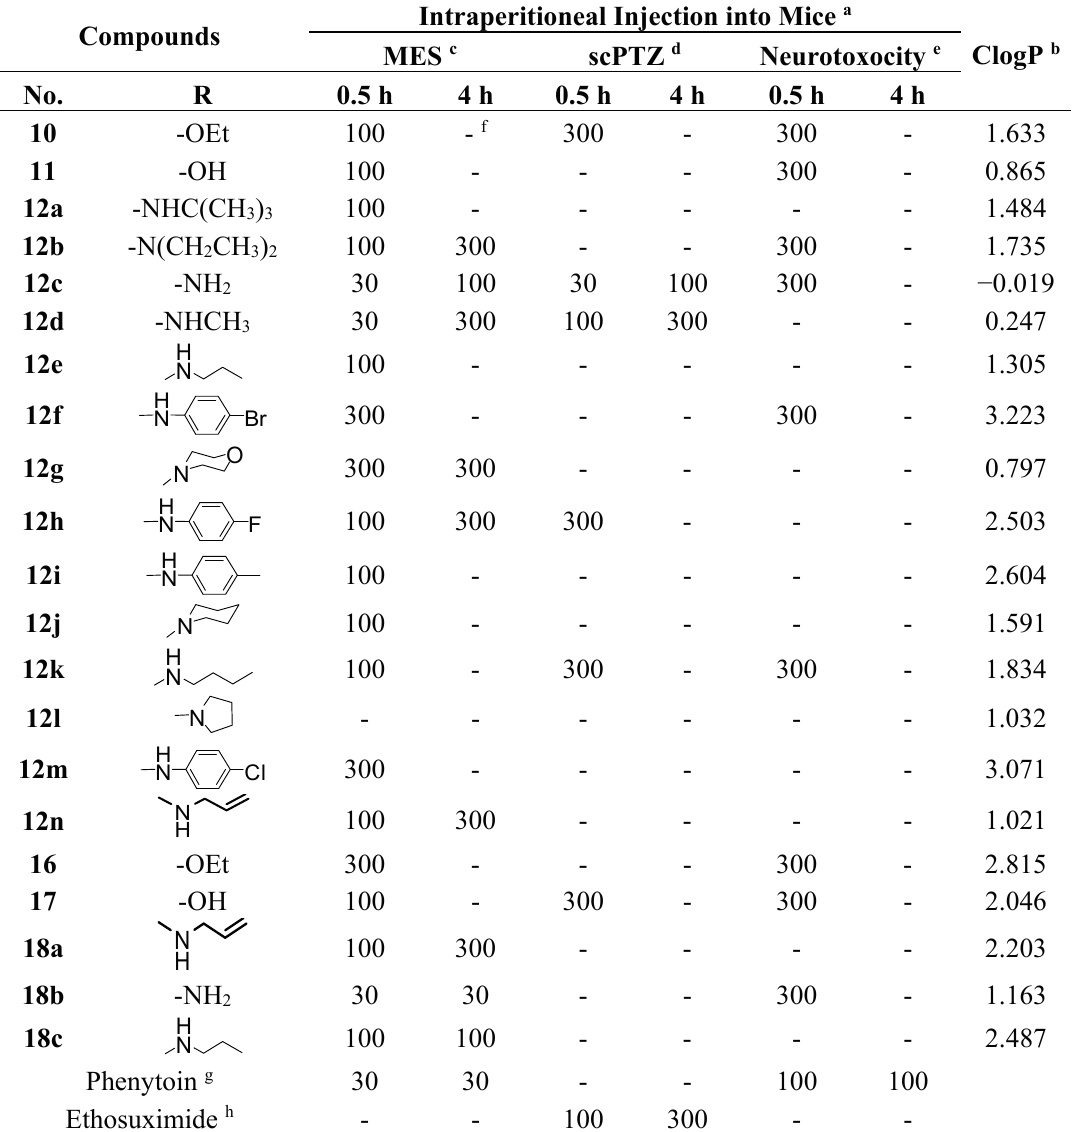
Table 1. Anticonvulsant activity and neurotoxicity of compounds administered intraperitoneally.